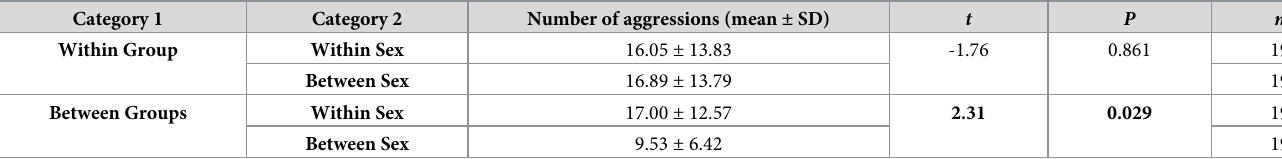
Table 2. Number of aggressive behaviours within and between capture-site groups.